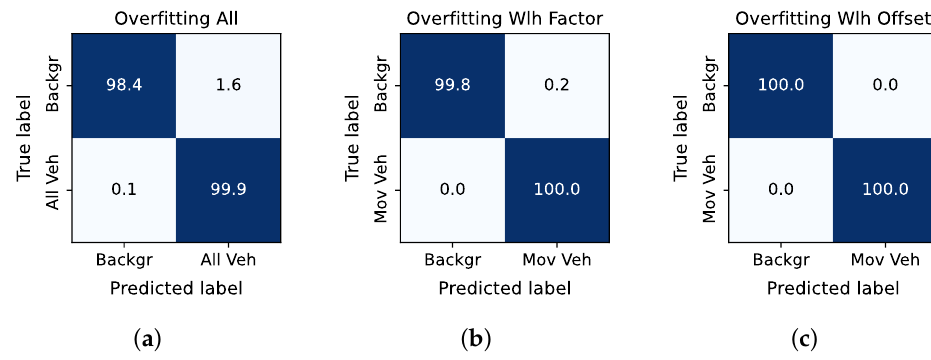
Figure 9. Overfitting confusion matrices. ( a ) Perfect overfitting is not achieved for the All Vehicle configuration scene on the left. ( b ) The Moving Vehicle data scene is not perfectly segmented when a wlh -factor is used. ( c ) Training with the same scene as in ( b ) results in a perfect score when an adequate wlh -tolerance is